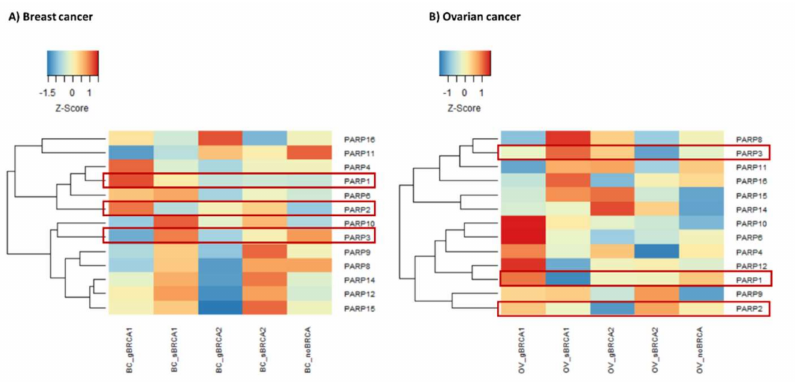
Figure 4. Heatmaps of poly(ADP-ribose) polymerase ( PARP) family genes expression in breast ( A ) and ovarian cancer ( B ) subgroups stratified by BRCA1 and BRCA2 mutations. The results show that the highest expression of PARP1 is associated with germline BRCA1 mutations, while the expression of other PARP genes varies depending on the disease, gene, and mutation